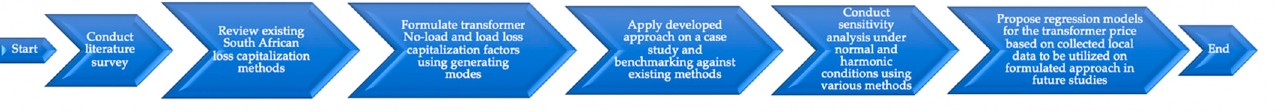
Figure 1. Graphical abstract.